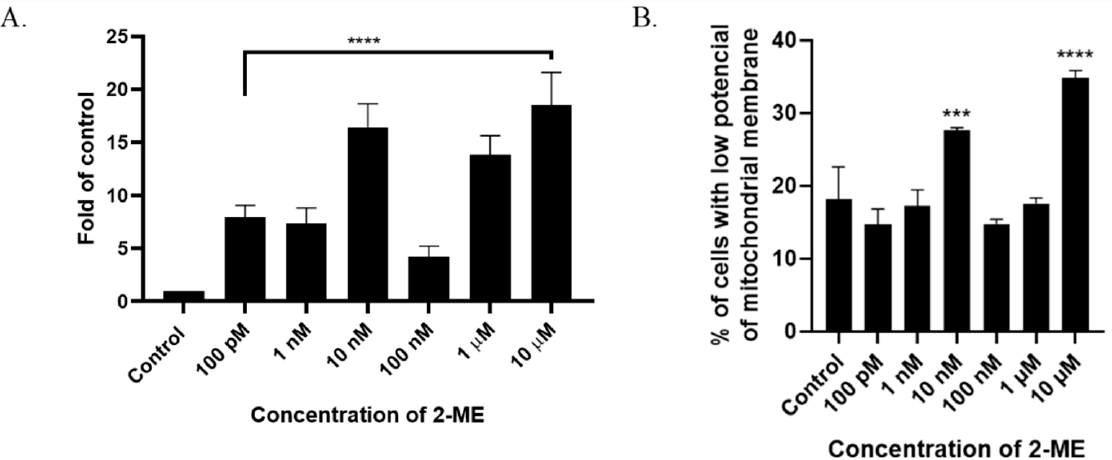
Figure 3. ( A ) 2-ME induces DNA strand breaks in SW1088 cells after treating cells with 100 pM–10 µ M 2-ME. Values are the mean ± SE of three independent experiments, expressed as fold change compared to control cells. The data were analyzed using GraphPad Software, Inc., version 8, USA, by performing a one-way ANOVA; **** p < 0.0001 vs. control. ( B ) 2-ME decreases mitochondrial membrane potential in SW1088 cells. Values are the mean ± SE of three independent experiments. The data were analyzed using GraphPad Software, Inc., version 8, USA, by performing one-way ANOVA; *** p < 0.001, **** p < 0.0001 vs. control.